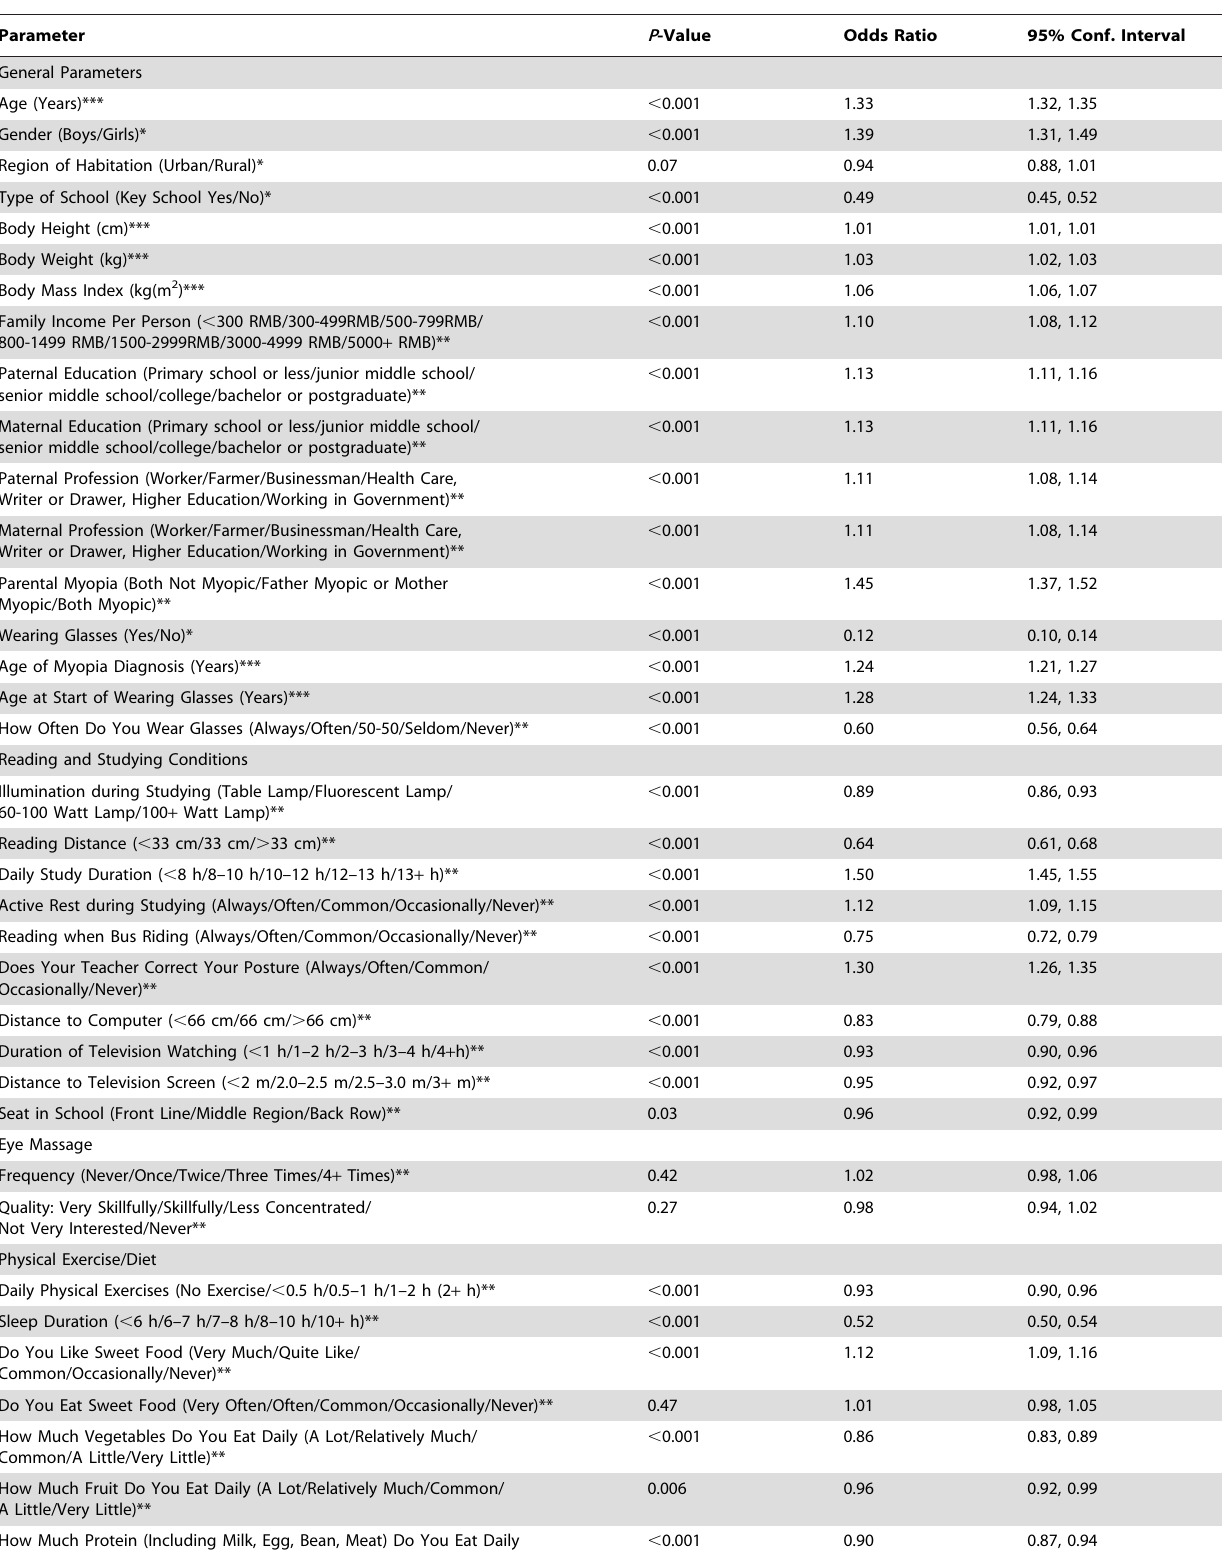
Table 1. Associations between the prevalence of myopia (defined as refractive error #2 1.00 diopters in the worse eye) and ocular and systemic parameters in the Beijing Pediatric Eye